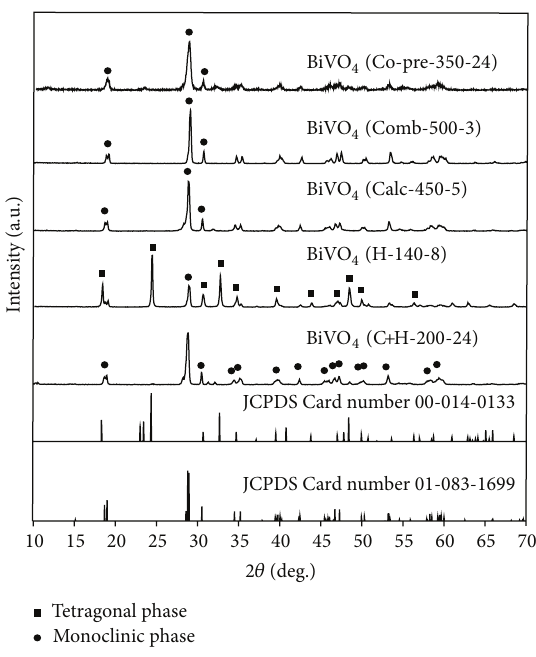
Figure 2: XRD patterns of BiVO 4 samples synthesized by various methods and conditions (according to Tables 1 and 2). Refer- ence tetragonal and monoclinic BiVO 4 are shown for comparison according to JCPDS Card numbers 00-014-0133 and 01-083-1699,